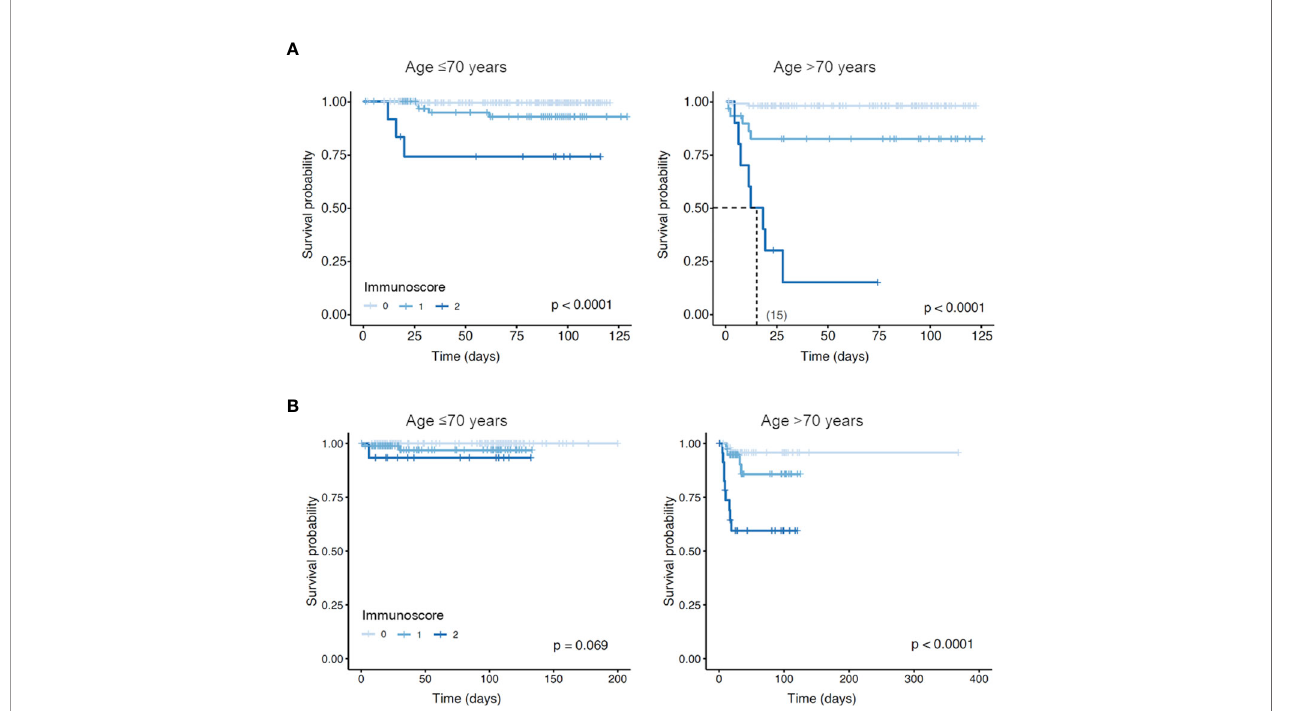
FIGURE 4 | Overall survival of patients with COVID-19 according to presence of two high-risk immune biomarkers identi fi ed in this study. (A) Patients had an immunoscore of 0, 1, or 2 according to the absence or the presence of one or two risk factors, respectively: <0.67% non-classical monocytes and <1% B cells. Among patients aged ≤ 70 years, 274, 80, and 12 had an immunoscore of 0, 1, or 2, respectively. Among patients aged >70 years, 107, 30, and 10 had an immunoscore of 0, 1, or 2, respectively. (B) This immunoscore was further validated in an independent cohort of additional 355 patients with COVID-19, where 126, 91, and 15 patients aged ≤ 70 years had an immunoscore of 0, 1, or 2, respectively; whereas 55, 43, and 25 patients aged >70 years had an immunoscore of 0, 1, or 2,